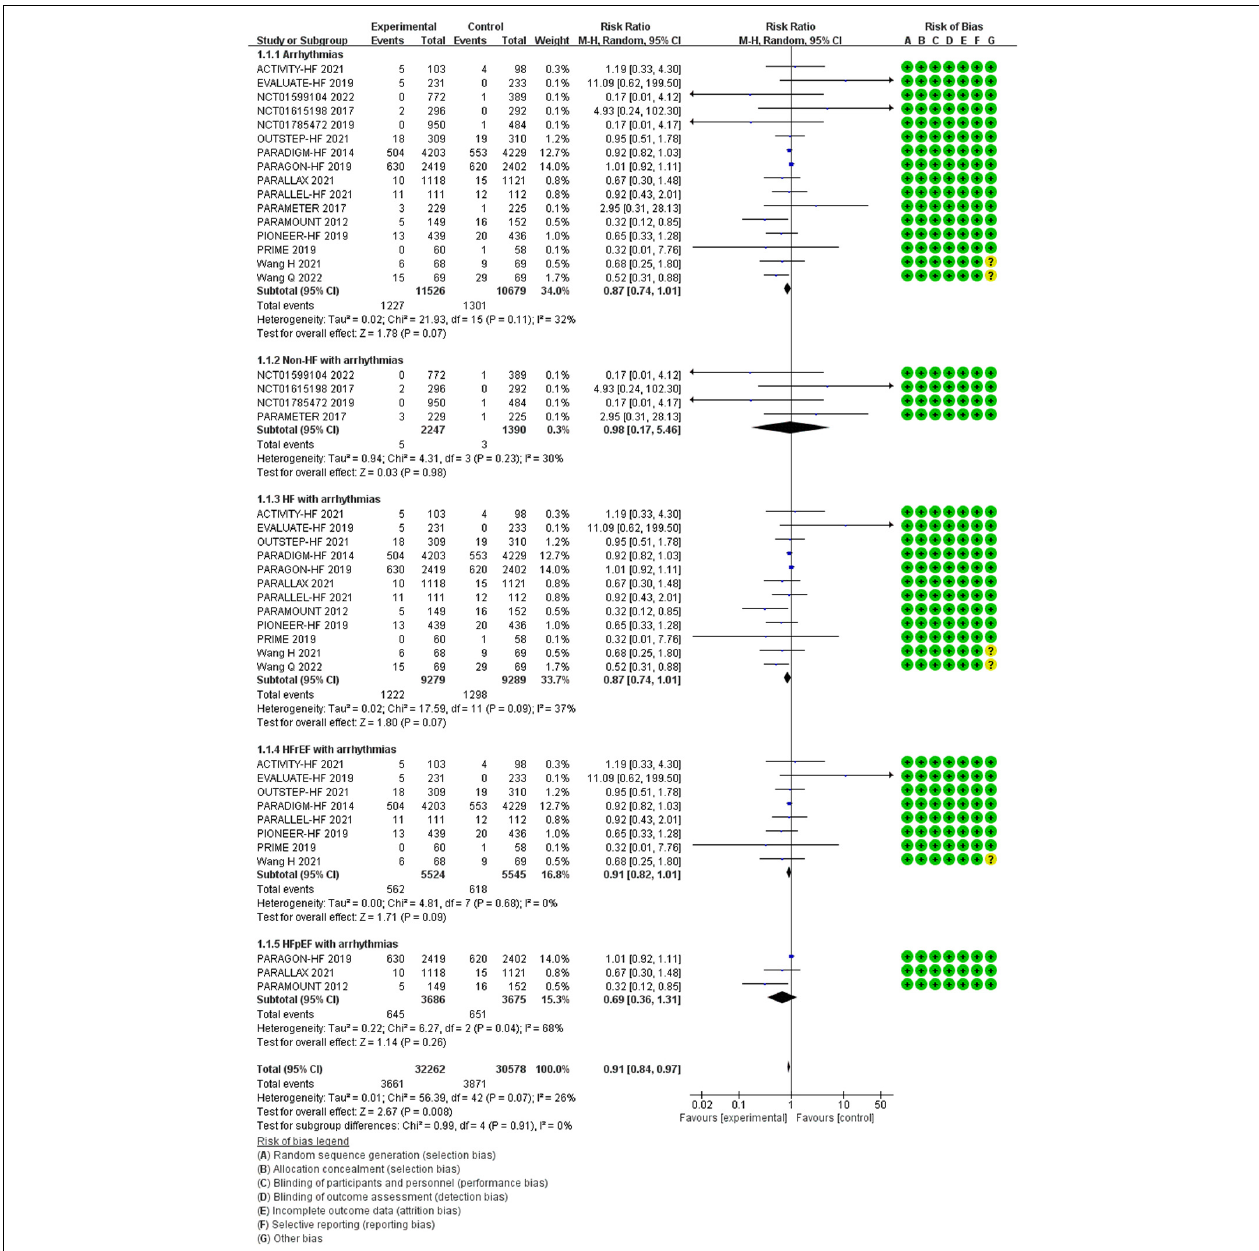
FIGURE 4 | The efficacy of SV compared to ACEI/ARB on